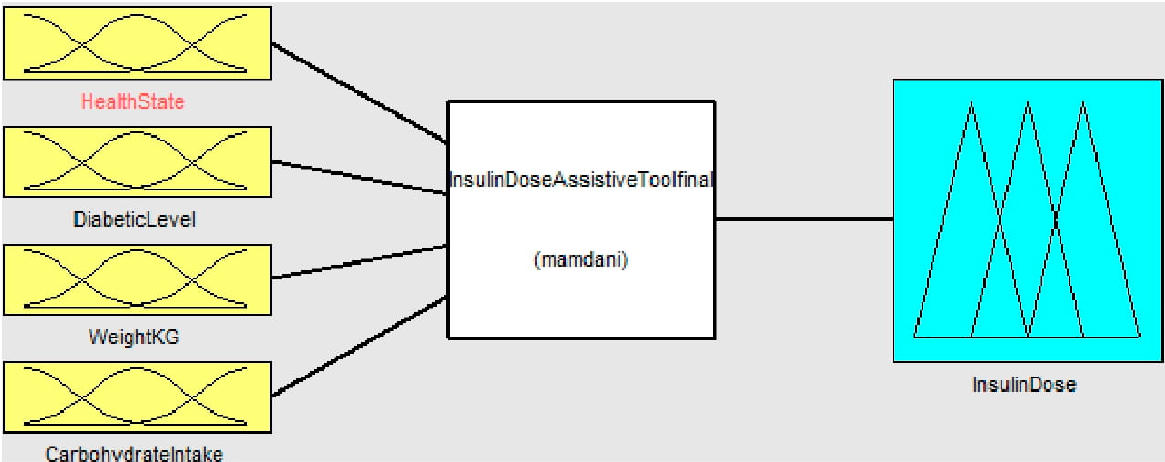
Figure 7. Insulin Dose Assistive Tool Overview.